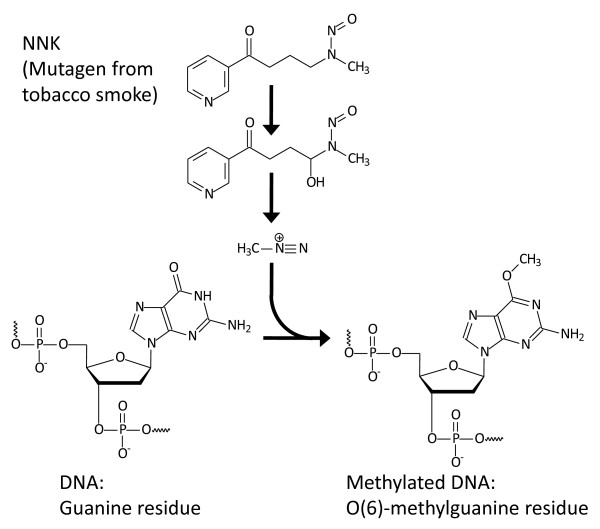
The tobacco specific nitrosamine 4-(methylnitrosamine)-1-(3-pyridyl)-1-butanone (NNK), and the proposed mechanism of guanosine methylation in DNA.